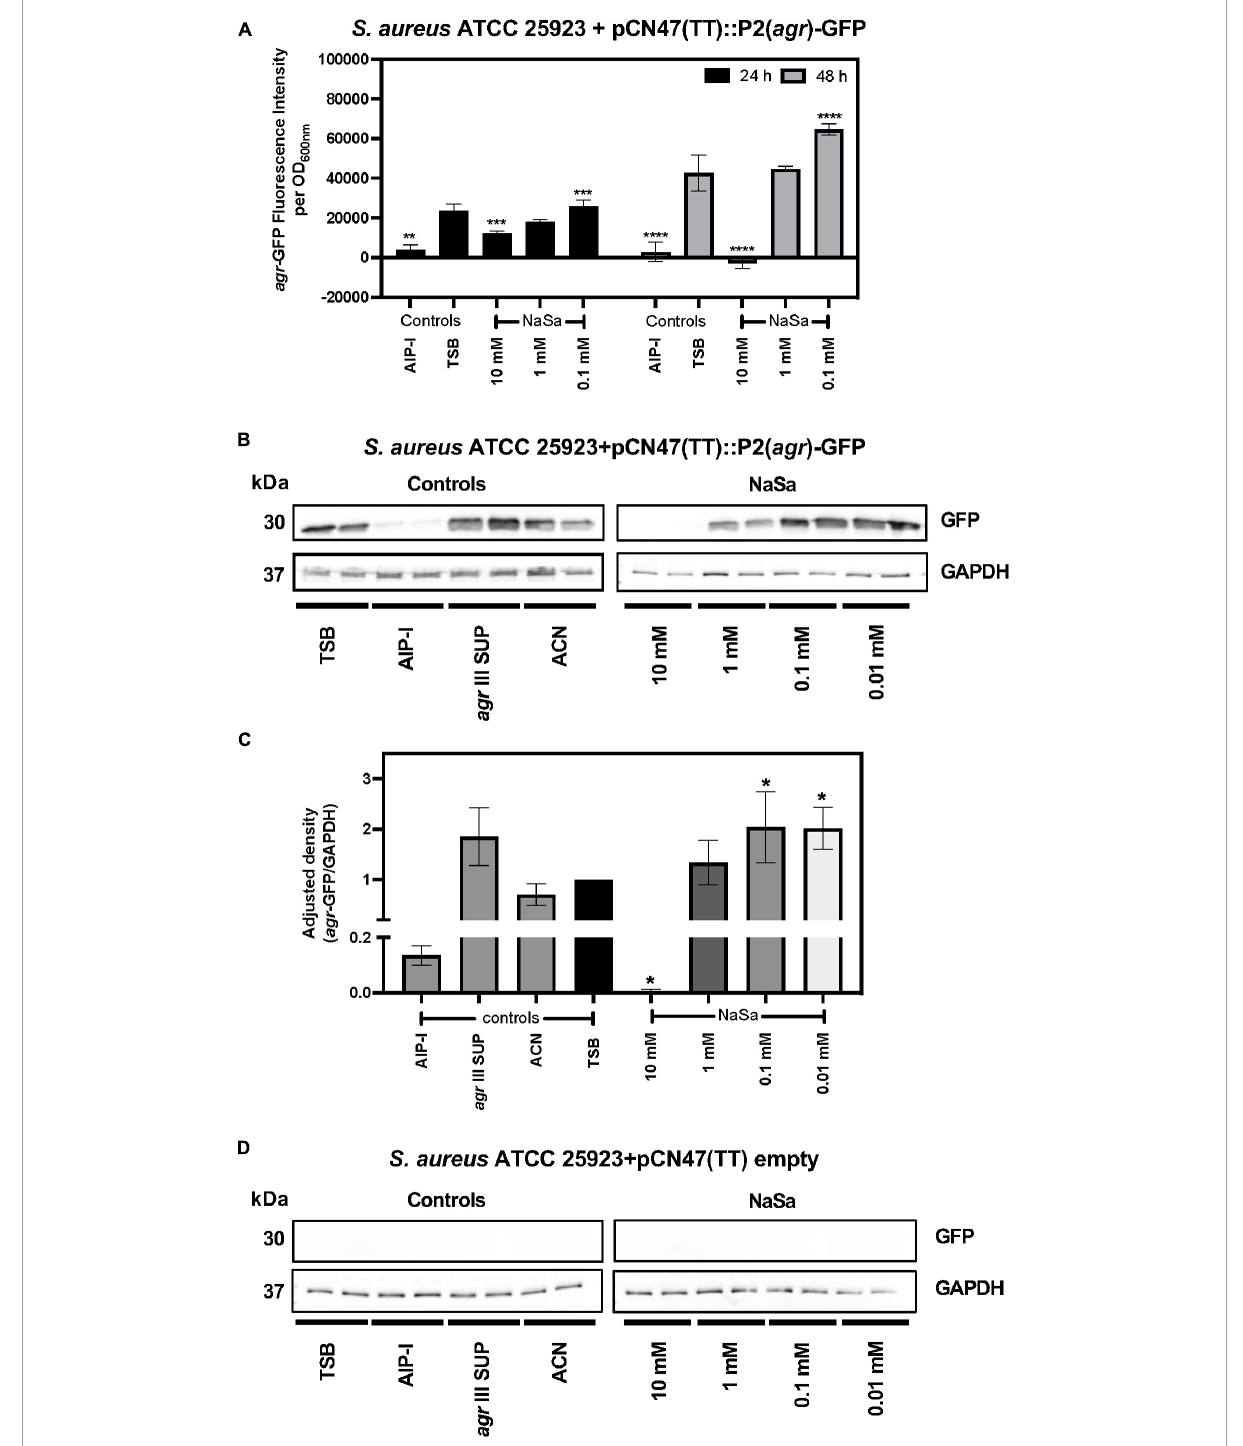
FIGURE1 NaSa affects the expression of agr in S. aureus . S. aureus ATCC 25923 + pCN47(TT):P2(agr)-GFP was used as a reporter strain to evaluate the potential quorum sensing inhibitory effects of NaSa. The effect of NaSa on agr -GFP fluorescence intensity after 24 and 48 h is shown in (A) , while the 24 h effect of NaSa on GFP production as result of the expression of agrBDCA under the P2 promoter is shown in (B,C) . GAPDH was used as a loading control for semiquantitative purposes (C–E) . A control strain with empty plasmid was used as negative control in (D) . The display images (B,D) are representative of three independent experiments. Each bar represents the mean from three independent experiments ± SD . * P ≤ 0.05, ** P ≤ 0.01, *** P ≤ 0.001, **** P ≤ 0.0001, statistically significant compared with TSB (Tryptic Soy Broth) as media using one-way ANOVA Dunnett’s test. AIP-I, Autoinducing Peptide-I; SUP, supernatant; ACN, acetonitrile, used as AIP-I diluent